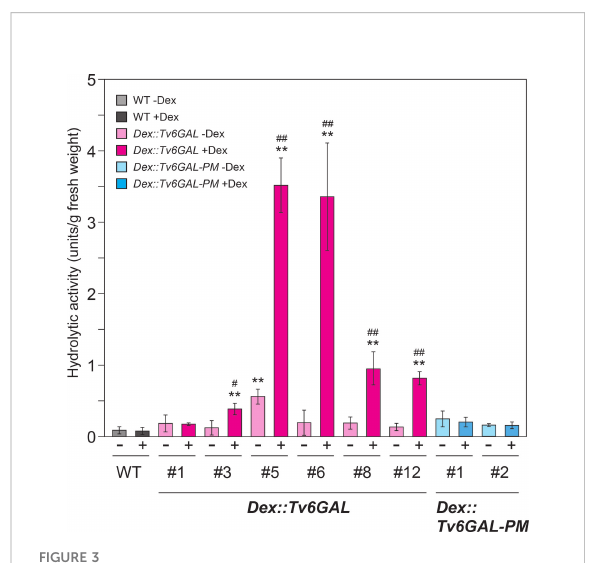
FIGURE 3 Enzymatic activity of Dex::Tv6GAL and Dex::Tv6GAL-PM plants. Endo- b -1,6-galactanase activity was measured using algal b -1,6- galactan as substrate. Endo- b -1,6-galactanase activity per g fresh weight is shown. Data are mean values with ± SD (n=3 biological replicates). Asterisks indicate differences from WT plants with Dex treatment (Student ’ s t -test, **, P <0.01) and hash marks indicate signi fi cant differences between seedlings with and without Dex treatment (Student ’ s t -test, #, P <0.05; ##, P